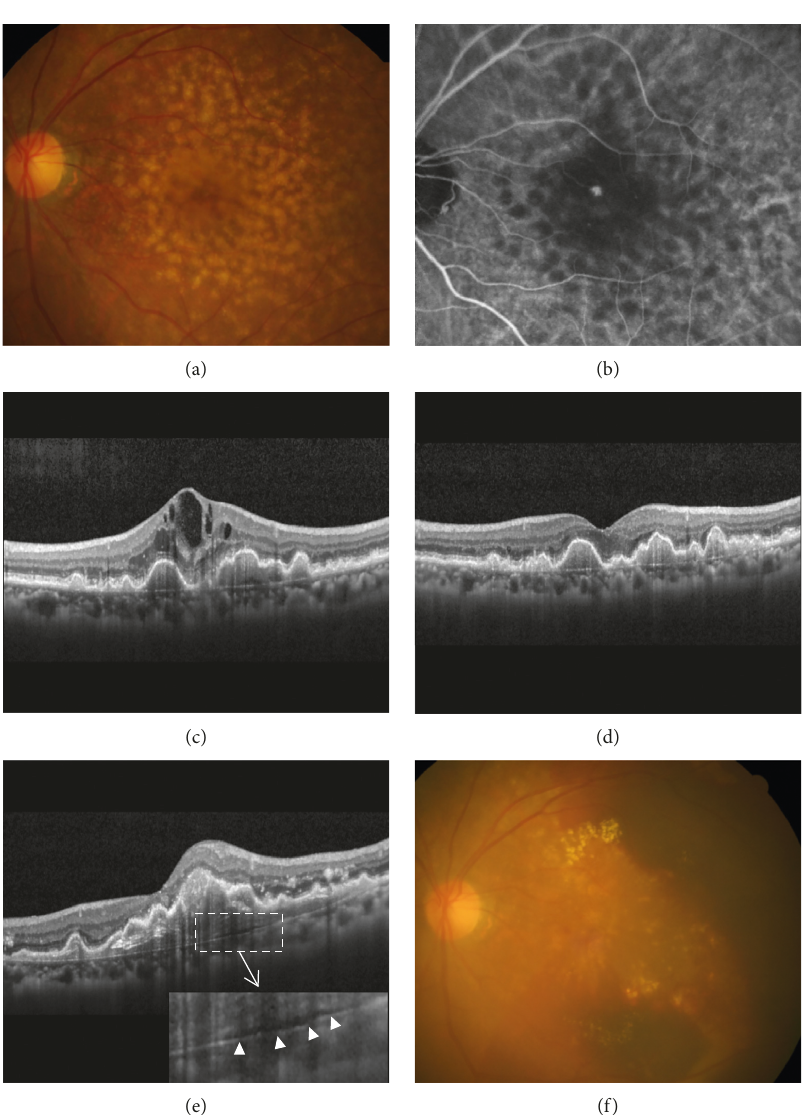
Figure 4: Fundus photography (a, f), indocyanine green angiography (b), and optical coherence tomography (c, d, e) images of a patient diagnosed with type 3 neovascularization. The images were taken at diagnosis (a–c), at 3 months (d), at 16 months (e), and at 17 months (f). After 3 monthly antivascular endothelial growth factor injections, the fluid was completely resolved (d). The patient was treated with anti- VEGF monotherapy during the follow-up period. Development of prechoroidal cleft was identified at 16 months (e) (arrowheads). One month later, subretinal hemorrhage developed (f). Nine antivascular endothelial growth factor injections were performed during the follow- up period.